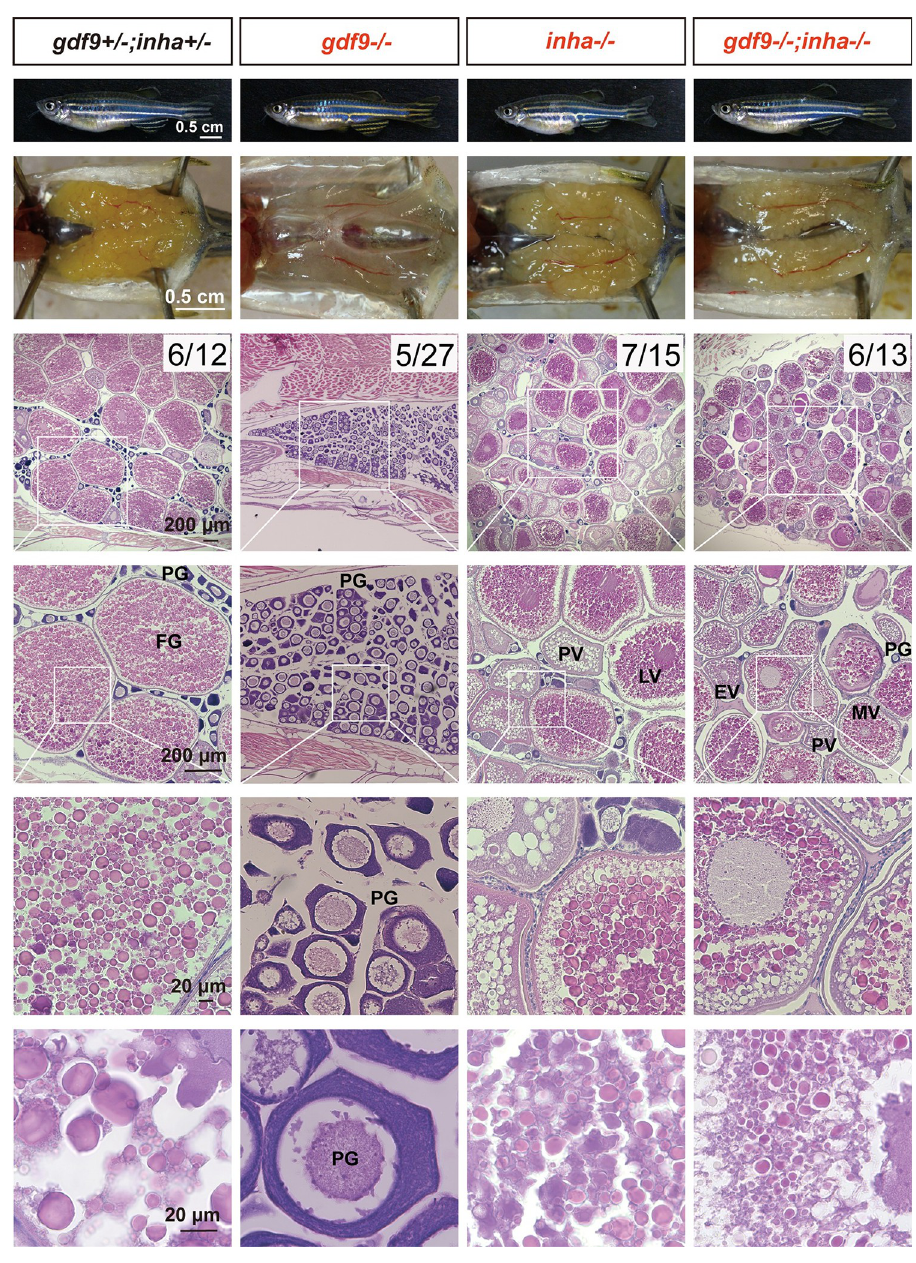
Fig 7. Rescue of follicle blockade in gdf9 mutant by mutation of inhibin α ( inha -/-). The follicles in gdf9 mutant ( gdf9-/- ) were arrested at PG stage at 90 dpf, and double mutation of gdf9 and inha ( gdf9-/-;inha-/- ) resumed follicle activation or PG-PV transition and vitellogenic growth. The numbers shown in the photos indicate the total number of fish examined (lower) and the number of female fish exhibiting similar phenotype to that shown (upper). PG, primary growth; PV, pre-vitellogenic; EV, early vitellogenic; MV, mid-vitellogenic; LV, late vitellogenic; FG, full-grown. pathway in the follicle for follicle cell-to-oocyte signaling [68,69]. The increased inhbaa expres- sion and loss of inhibin in the gdf9 and inha double mutant ( gdf9-/-;inha-/- ) would enhance such signaling by activin. To provide further evidence for direct actions of activin on oocytes, we examined Smad2/3 phosphorylation in PV oocytes in response to activin treatment in